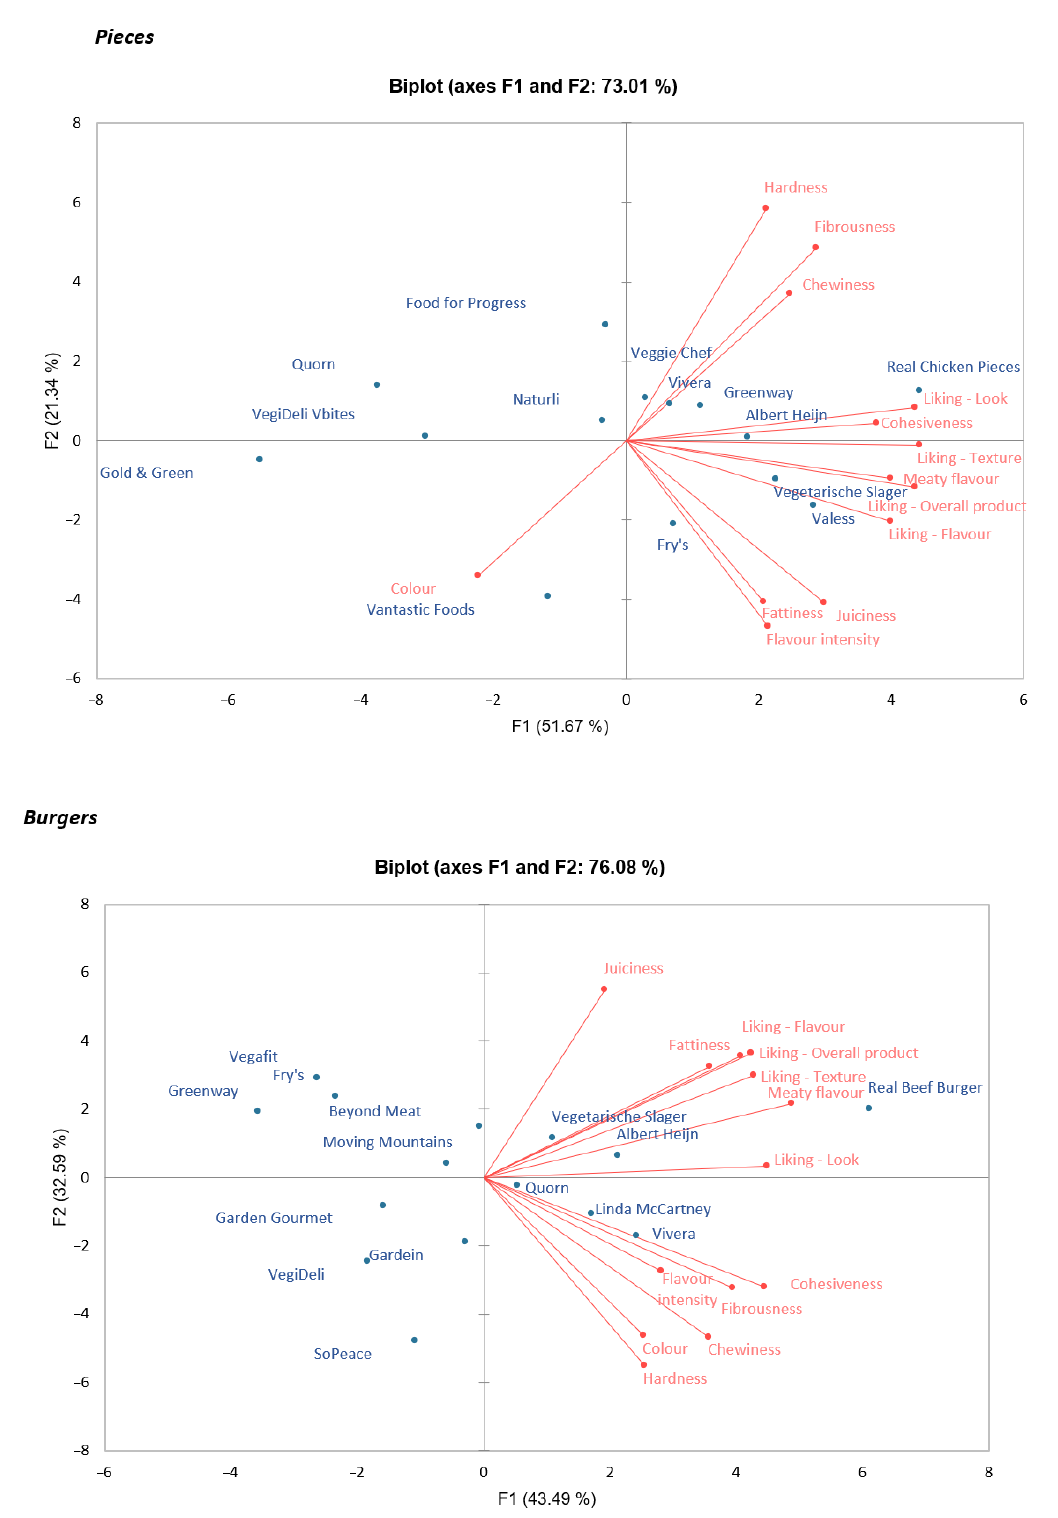
Figure 2. PCA plots for chicken pieces ( top ) and burgers ( bottom ). The different products are indicated in blue, and the attributes and liking are given in red. For chicken pieces, F1 relates to colour, liking and cohesiveness, and meaty flavour, and F2 related to most texture and mouthfeel attributes. For burgers, F1 relates to liking, meaty flavour, and fattiness, and F2 relates to juiciness, colour, and texture and mouthfeel attributes.